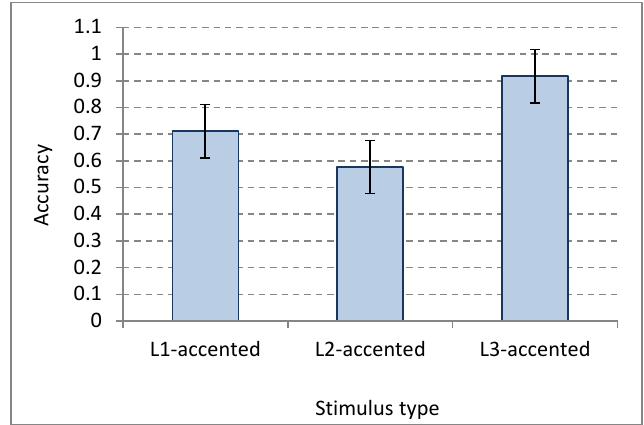
Figure 9. Perception accuracy of rhotics according to stimuli types (L1-accented, L2-accented, L3-accented), with 0.95 confidence intervals as whisker bars.